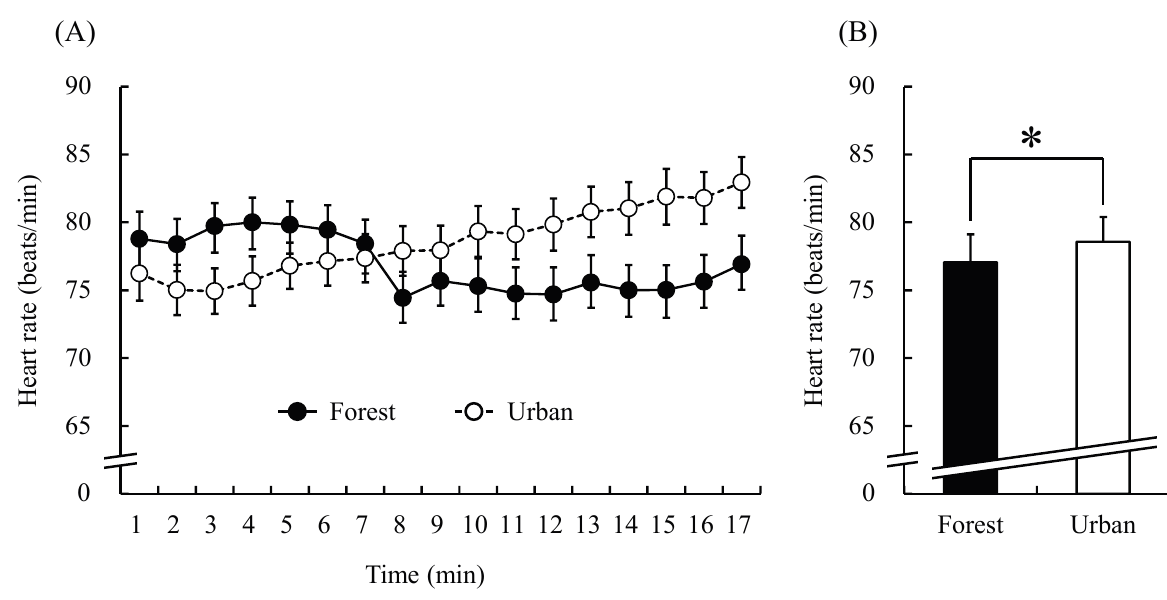
Figure 3. Heart rate during the forest and urban walk. ( A ) Changes in each 1-min heart rate value over the 17-min walk. ( B ) Overall mean heart rates. N = 19, mean ± standard error. * p < 0.05, paired t -test.